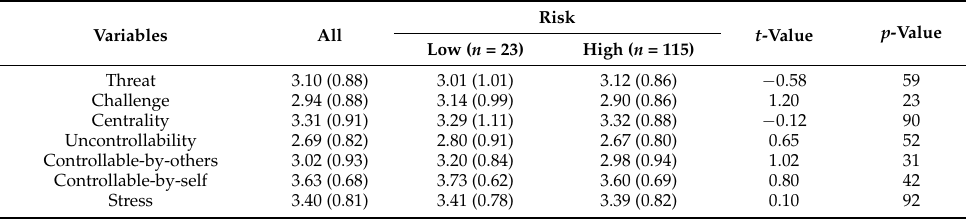
Table 6. Cognitive appraisals and stress perceptions (means and standard deviations) of biomedical scientists as a function of risk exposure to patients with